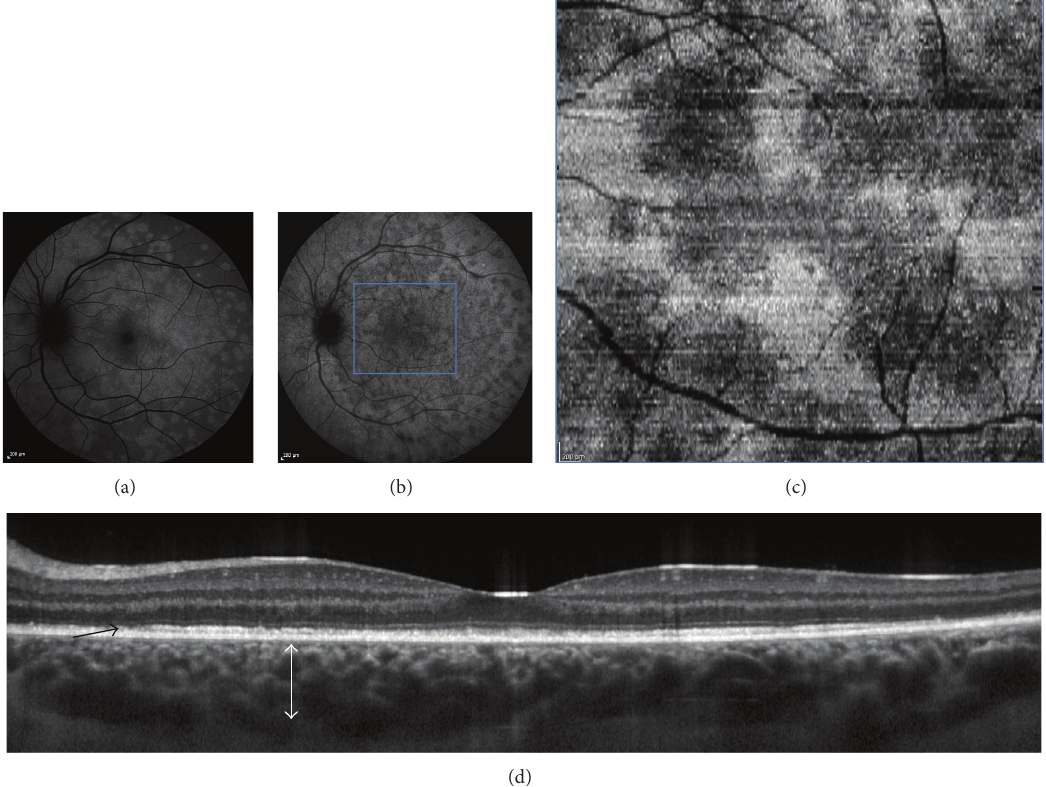
Figure 1: (a) Autofluorescence with hyperautofluorescent areas in the midperiphery of fundus; (b) indocyanine green angiography (ICGA) with hypofluorescent areas; (c) “en-face” EDI SD-OCT (enlarged view) at the level of the ellipsoid zone with hyporeflective areas; (d) B-scan EDI SD-OCT with disruption of the ellipsoid and interdigitation zones (black arrow). The choroid is thickened (white arrow).